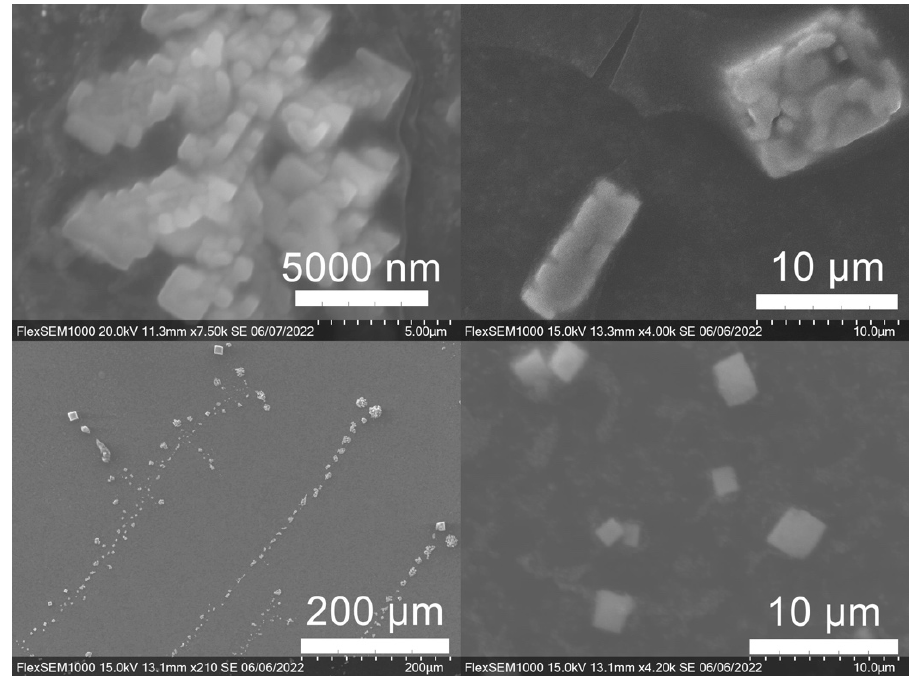
Figure 10. Gold (Au) nanoparticles synthesized with dark roast coffee grounds from espresso brew (SDE) forming larger superstructure assemblies.